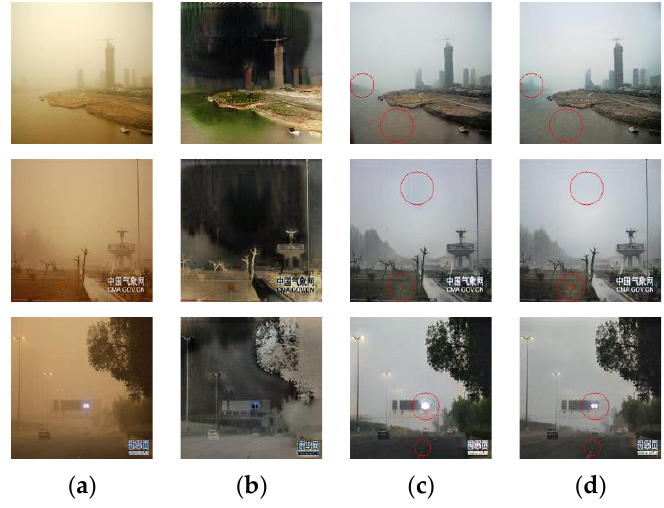
Figure 6. Subjective effects of different loss functions; ( a ) Sand-dust images; ( b ) No color identity preservation loss; ( c ) No dual-scale semantic perceptual function; ( d ) The complete network model. Note that “ 中国气象网 ” and “ 新华网 ” here denote China Meteorological Network and Xinhua Net- work, respectively. They indicate the source of the image.